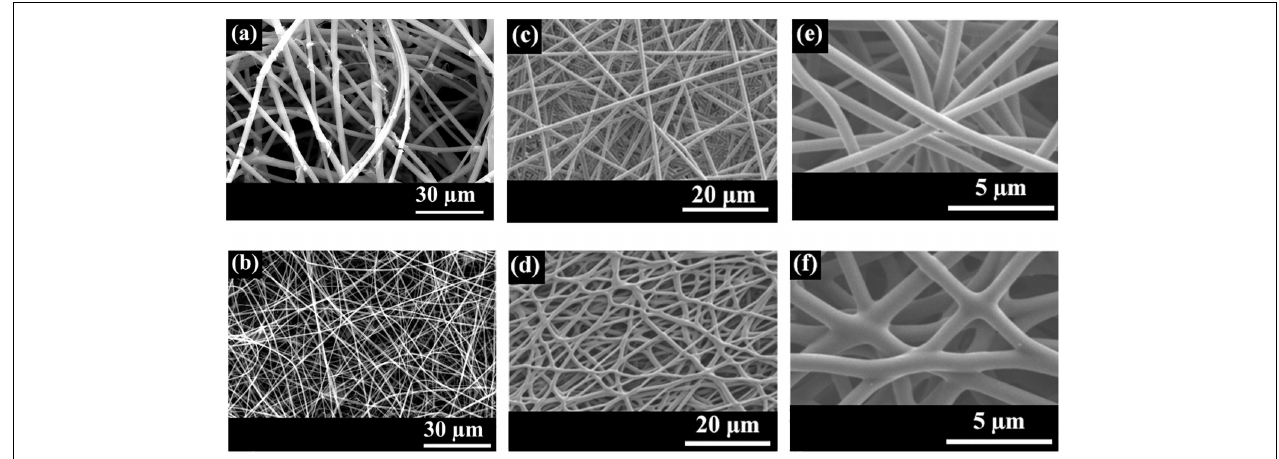
FIGURE 4 | SEM images of softwood kraft lignin electrospun fibers and carbonized fibers. (a) fibers from aqueous NaOH solutions of 7% (lignin/PEO: 95/5) (PEO, M v = 5 × 10 6 g/mol), (b) fibers from solution of 11% (lignin/PEO: 95/5) (PEO, Mv = 5 × 10 6 g/mol) in DMF, (c) thermostabilized non-bonded fibers from high molecular weight fraction of lignin and PEO (M v = 1 × 10 6 g/mol), (d) thermostabilized bonded fibers from a 70/30 wt% blend of high and low molecular weight fraction of lignin and PEO (M v = 1 × 10 6 g/mol), (thermostabilization at 250 ◦ C and a heating rate of 5 ◦ C/min), (e,f) carbonized fibers of (c,d) at 1000 ◦ C. (a,b) Poursorkhabi et al. (2015) (License CC BY-NC-ND, John Wiley and Sons). (c–f) Reprinted with permission (Dallmeyer et al., 2014) (License Number 4806541107321), WILEY-VCH Verlag GmbH & Co. KGaA,